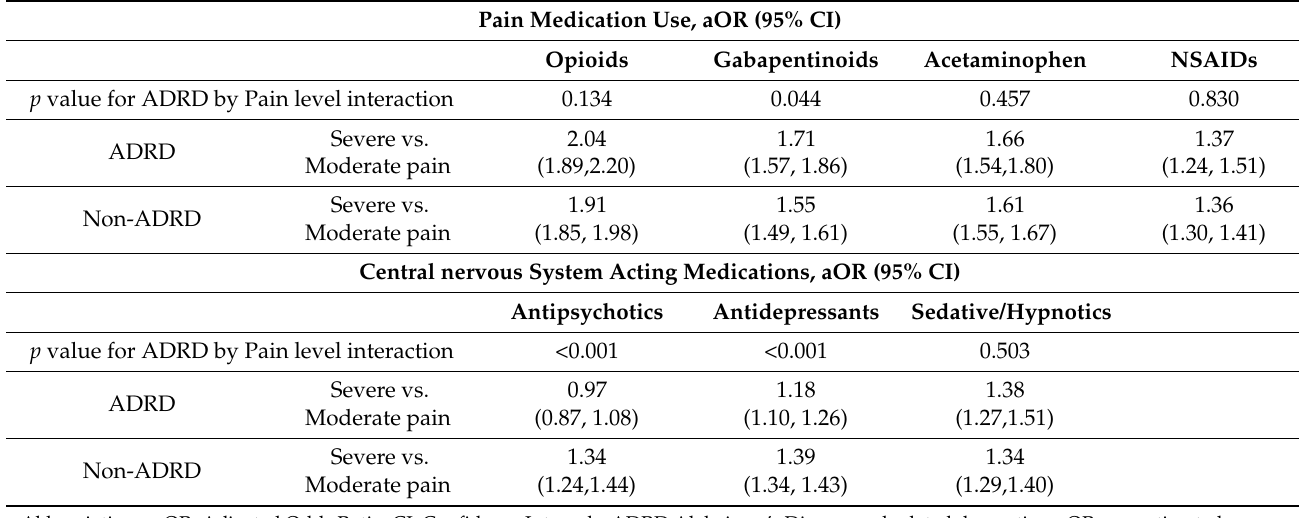
Table 4. Interactions associations between ADRD by pain intensity for pain medication and central nervous system acting potentially inappropriate medications use during 90-days prior to hospitalization in FY 2013 among 96,224 veterans 65 and older with moderate to severe